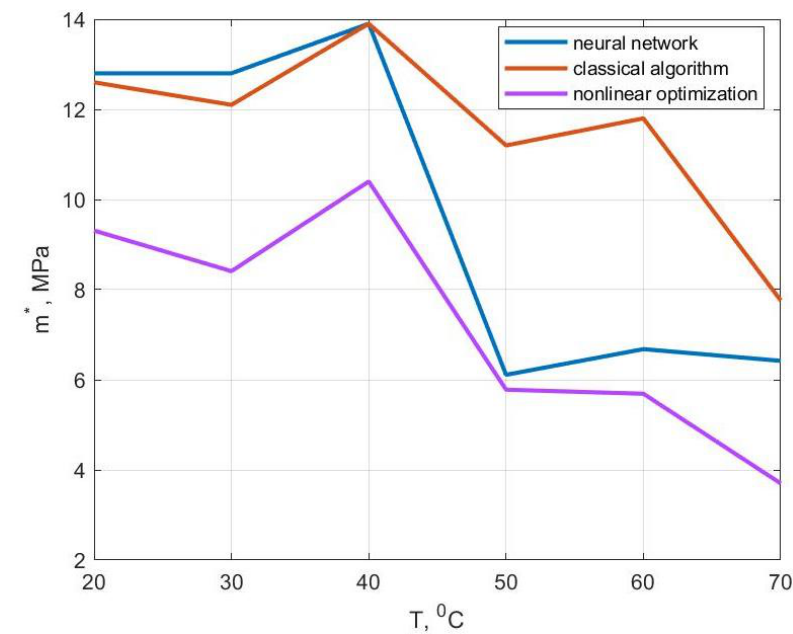
Figure 12. Comparison of the velocity modulus values obtained by different methods.